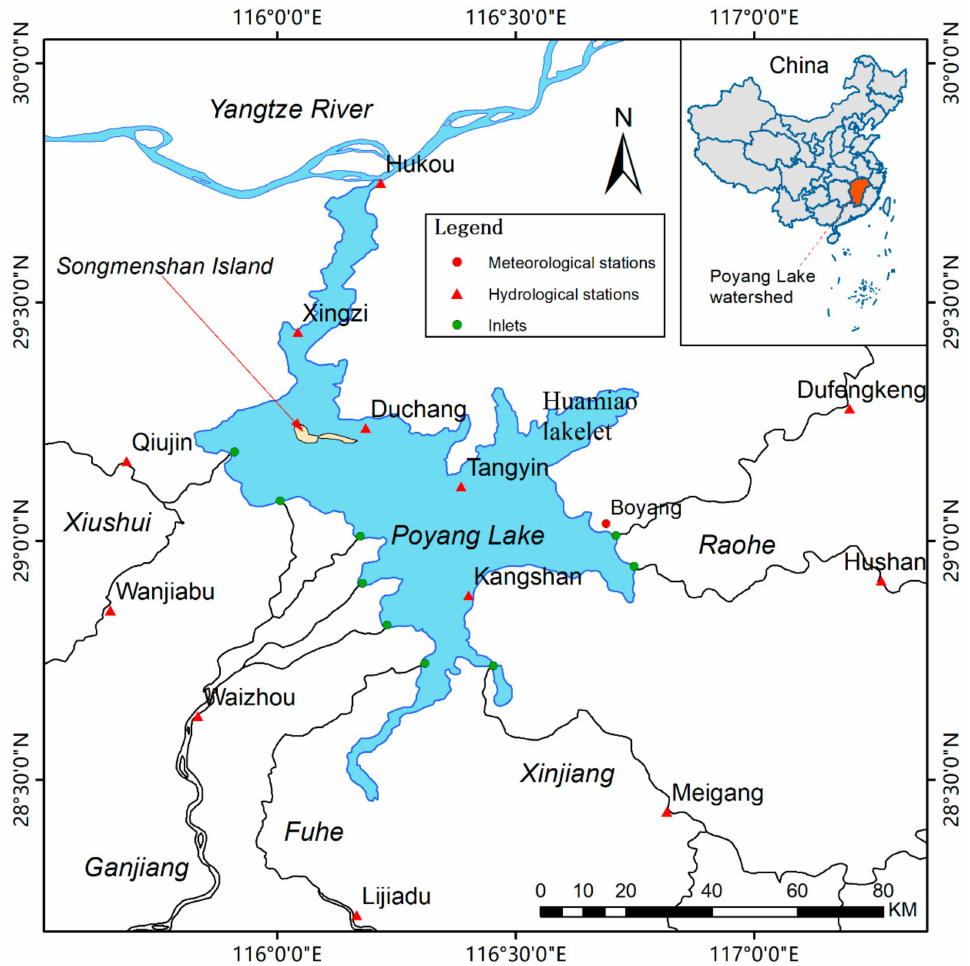
Figure 1. The location of Poyang Lake, the inflow tributaries, and the hydrological and meteorological stations. The daily river discharge and water level data during 2011 to 2015 at di ff erent hydrology gauging stations were collected from the Yangtze River Water Resources Commission and Hydrological Bureau of Jiangxi Province. The water level and water flux records were collected at Hukou station, which is located at the junction of Poyang Lake and the Yangtze River. Meteorological data at Boyang meteorological station, representing the weather that occurred over the Poyang Lake, was collected from the China Meteorological Data Sharing Service System (http: // cdc.nmic.cn / ). Field observations were conducted from July 15 to 23 in 2011 to measure in-situ data, including the turbidity, water depth, and suspended sediment concentration (SSC) of 50 water samples (Figure 2). Additionally, a satellite image Landsat ETM + (Enhanced Thematic Mapper plus) was used to extract information on the sand dredging activities, in order to simulate the suspended sediment transport considering the e ff ect of dredging activities during July